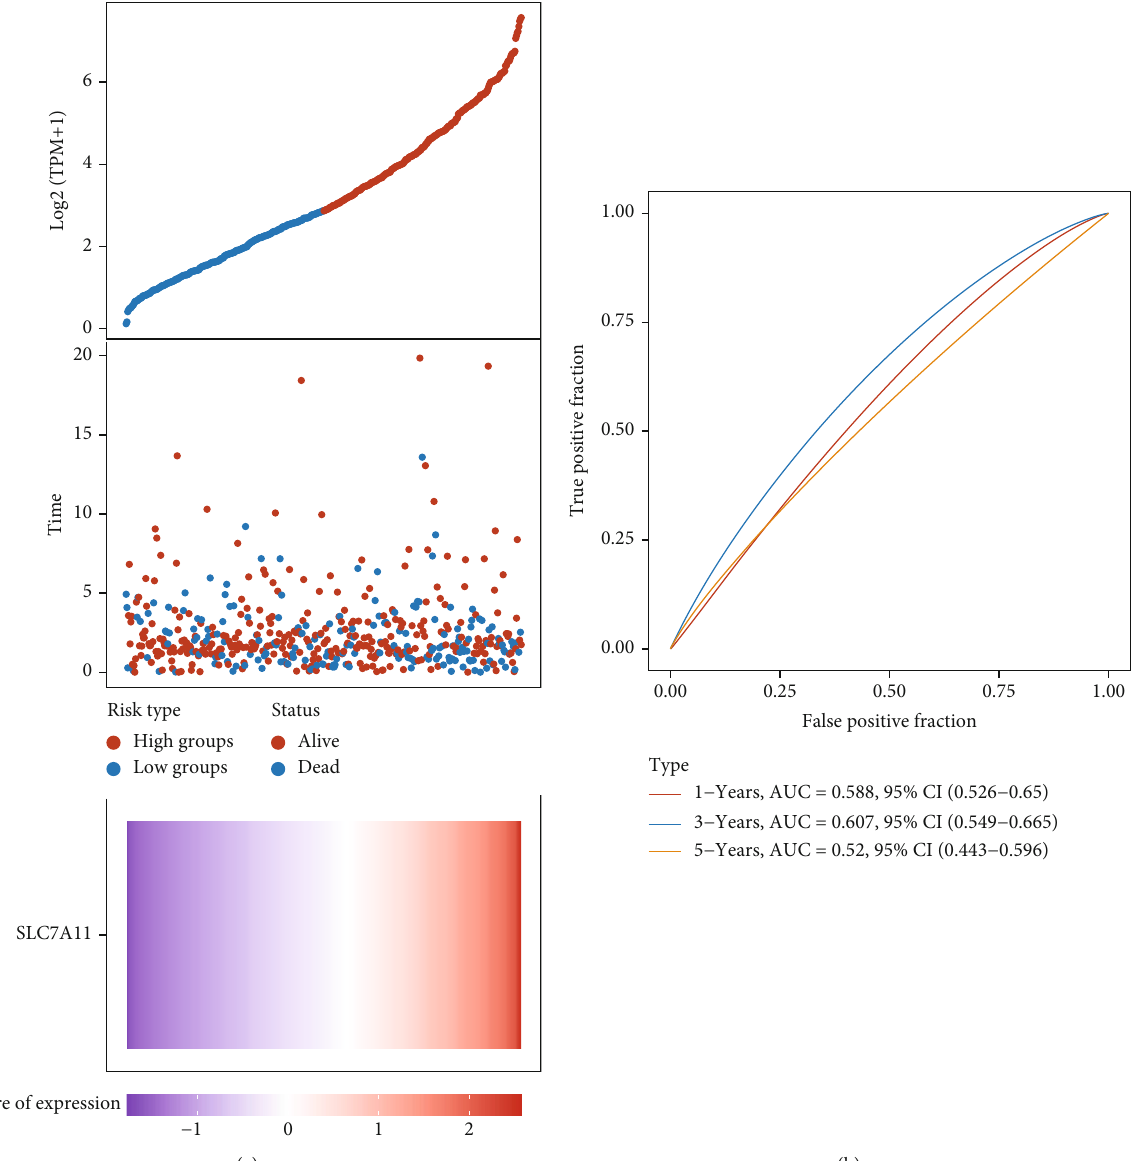
Figure 3: (a) The curve of risk scoring. Survival status of the patients. (b) Time-reliant ROC analyses for